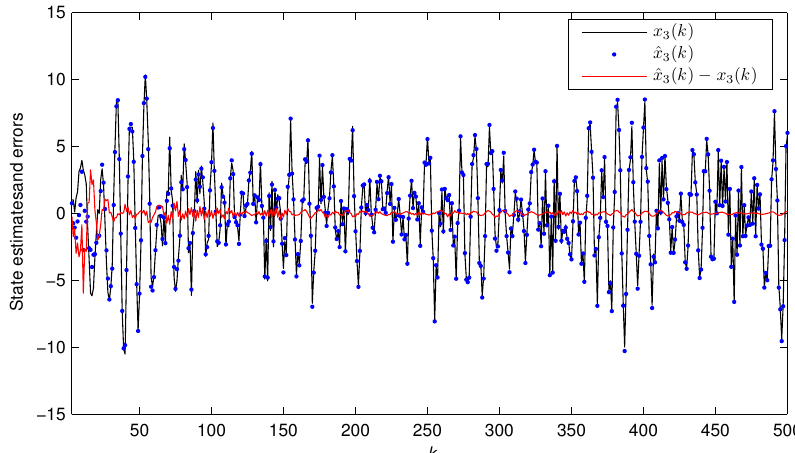
Figure 11. The true state x 3 ( k ) and the estimated state ˆ x 3 ( k ) versus k for Example 2 ( δ =